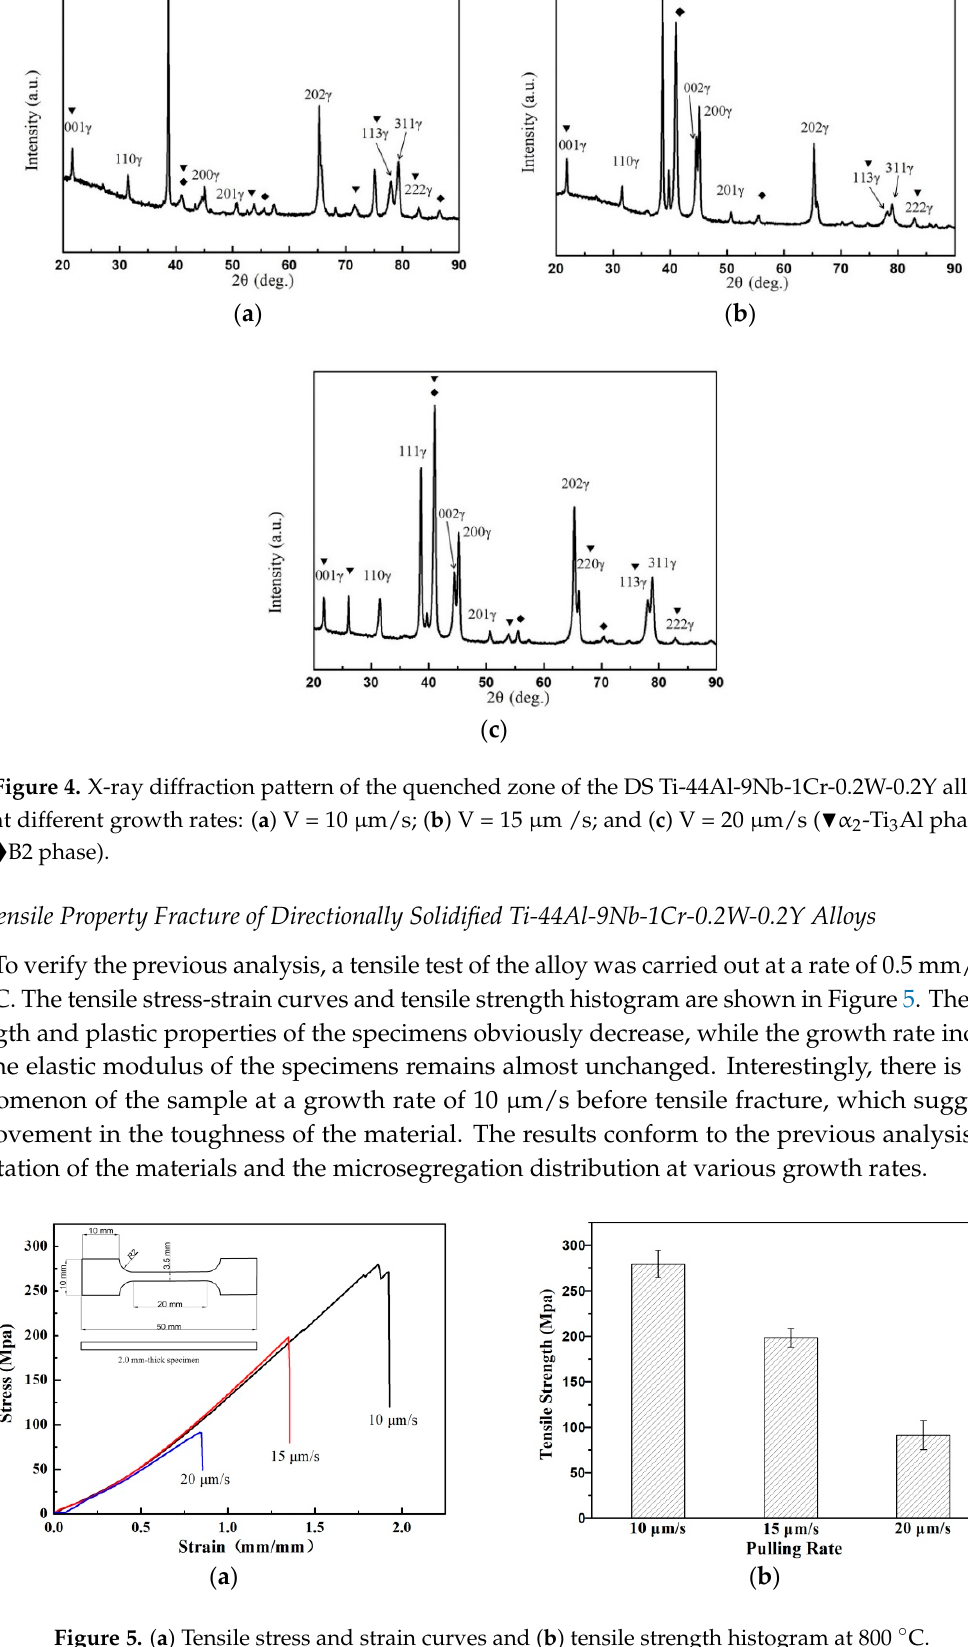
Figure 5. ( a ) Tensile stress and strain curves and ( b ) tensile strength histogram at 800 °C.